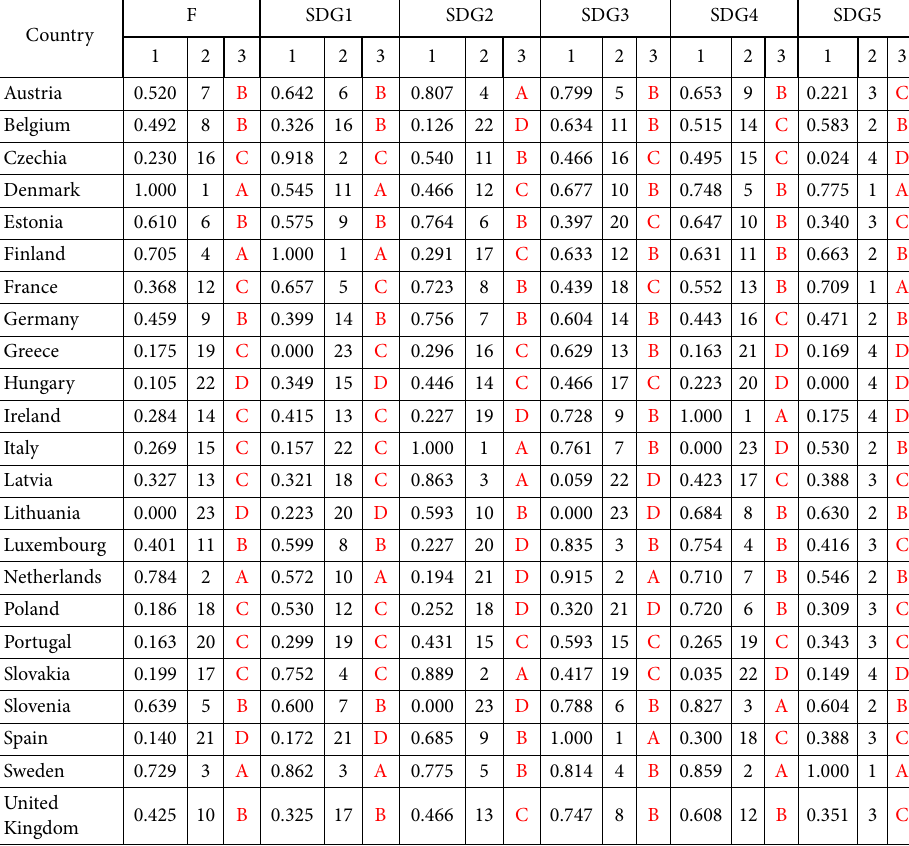
Table 1. The results of rankings in each considered areas of sustainable development and finance F Country